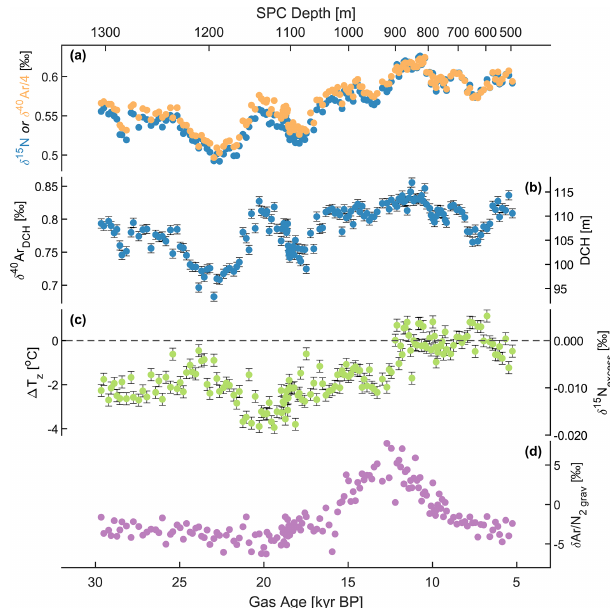
Figure 1. (a) SPICEcore measurements of δ 15 N and δ 40 Ar. The δ 40 Ar data are divided by 4 so that they can be plotted on the same axis as δ 15 N, with the visual offset between the two isotope ra- tios equal to δ 15 N excess (or, equivalently, (cid:49)T z ). (b) The firn dif- fusive column height (DCH) and (c) temperature difference ( (cid:49)T z ) and equivalent isotope parameters (see Sect. 2 for explanation). (d) SPICEcore measurements of δ Ar / N 2 after correction for grav- itational fractionation. All data are plotted on the bottom x axis on the SPC19 gas chronology. The corresponding depths in SPICEcore are indicated on the top x axis. Error bars in DCH and (cid:49)T z repre- sent 1 pooled standard deviation of replicate samples. Error bars for δ 15 N, δ 40 Ar / 4, and δ Ar / N 2grav are smaller than the data